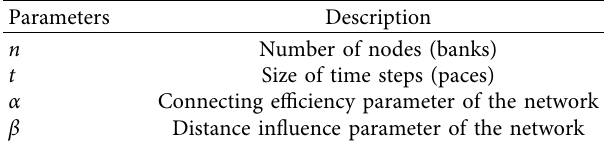
Table 1: Description of parameters.